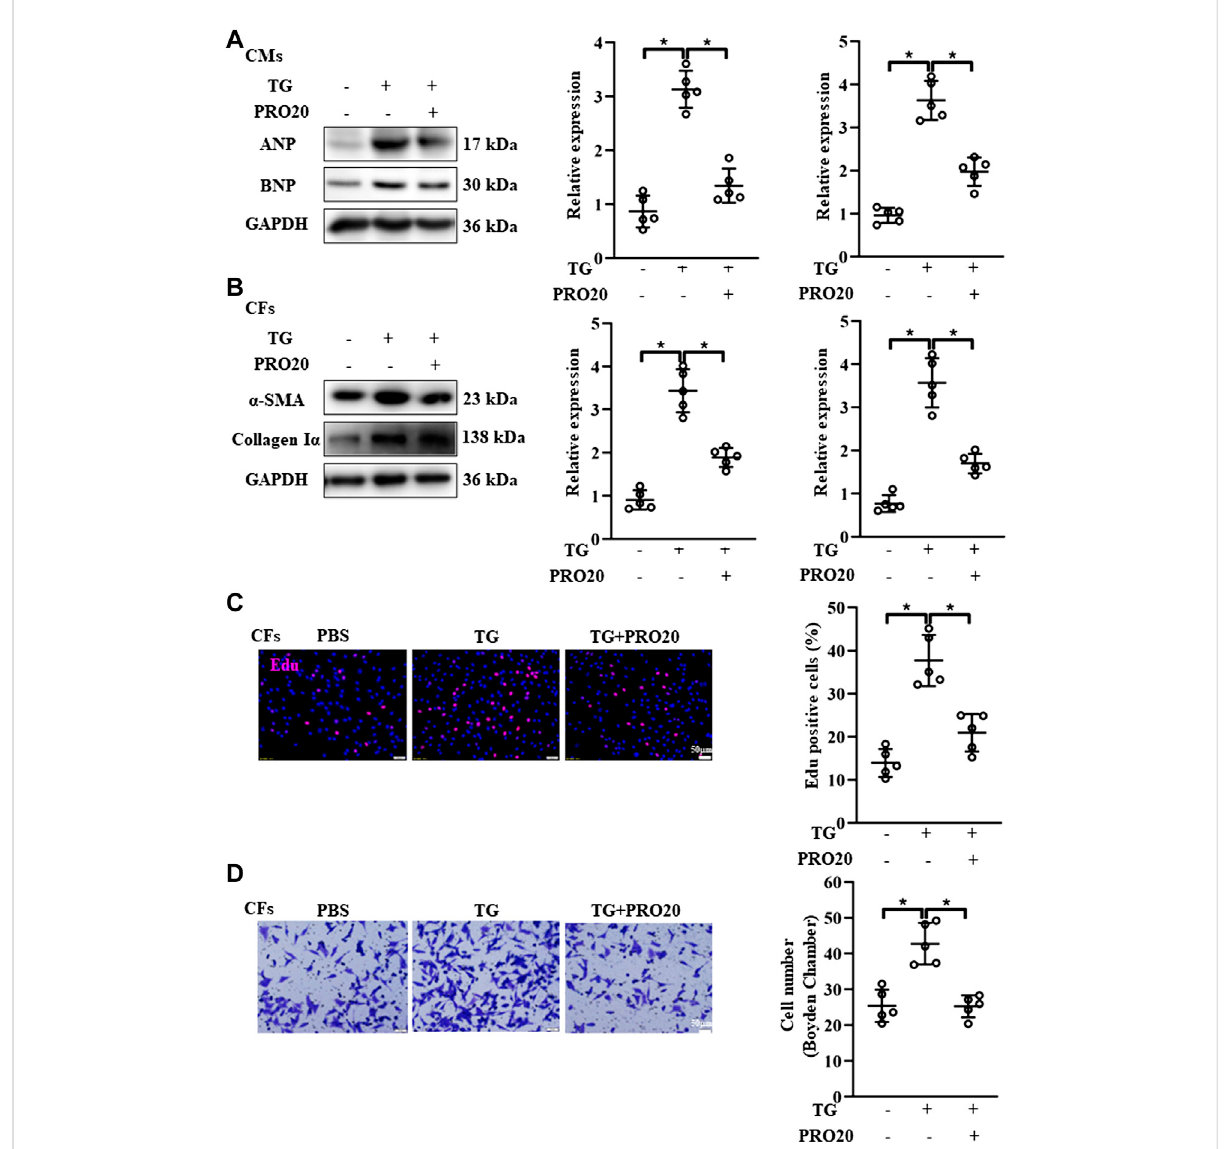
FIGURE 6 Effects of PRO20 on CM hypertrophy and CF activation induced by ER stressor TG. (A) Immunoblot analysis of ANP and BNP in TG-induced (5 μ M) CMs with and without PRO20 treatment and quantitative analysis of the ANP and BNP protein level normalized to GAPDH. (B) Immunoblot analysis of α -SMA and Collagen I α in CFs with and without TG treatment and quantitative analysis of the α -SMA and Collagen I α protein level normalized to GAPDH. (C) Effect of PRO20 on TG-induced CF proliferation assessed by Edu assay in indicated groups. (D) Boyden chamber assay was performed to evaluate the migration of CFs in indicated groups. p p -value < 0.05. n = 5 per group. Data are expressed as mean ±